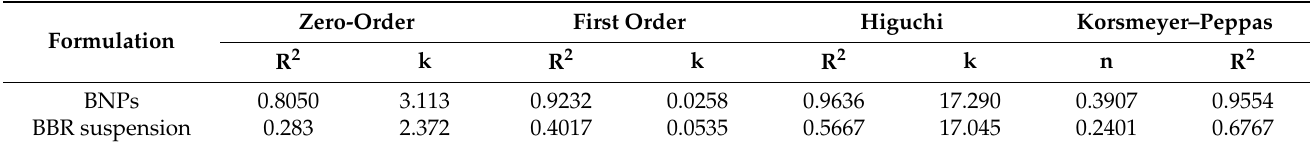
Table 3. Regression coefficient (R 2 ), release exponent (n) from the kinetic equations.